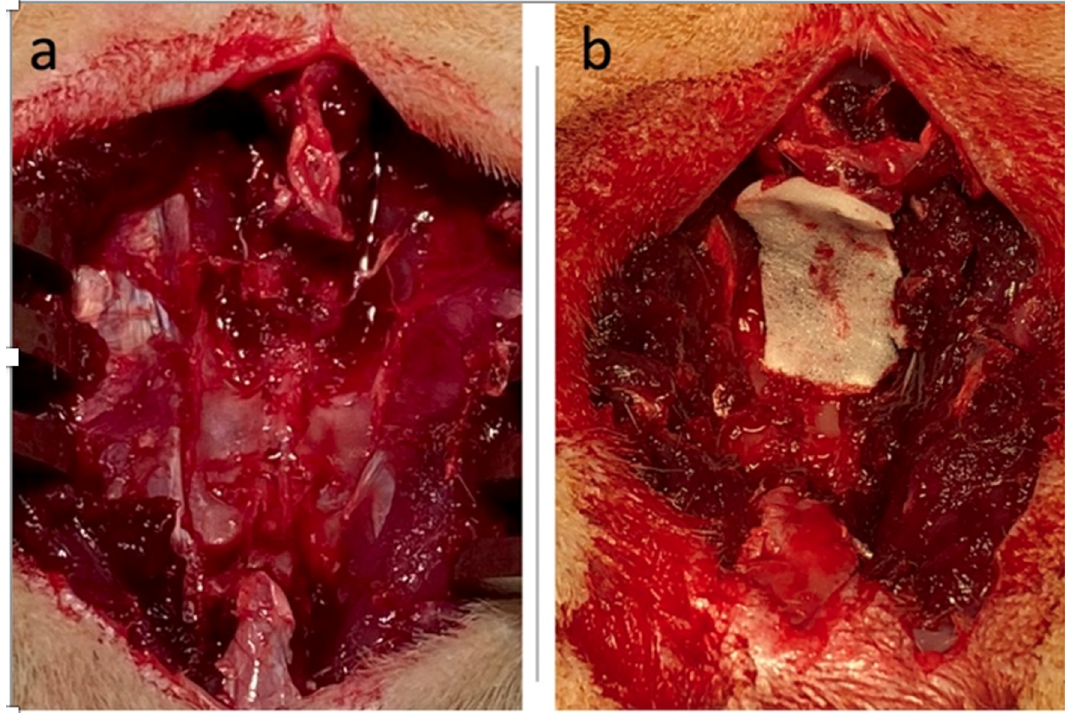
Figure 4. Dura theca and nerve root were covered with the inner layers of the CMC-BSP-RES sponge in the treatment group after laminectomy. ( a ) Control group; ( b ) treatment group.